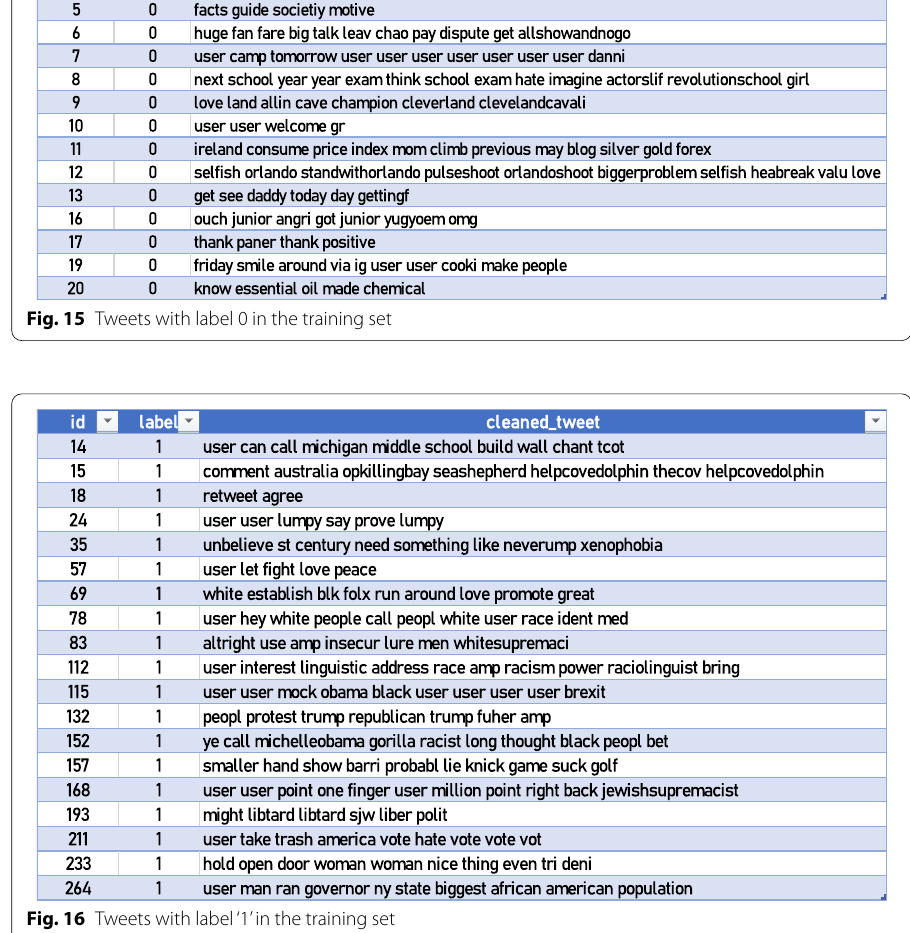
Fig. 16 Tweets with label ‘1’ in the training